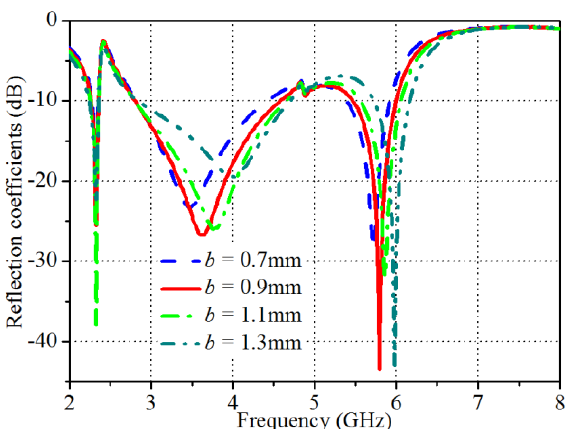
Figure 6: Effect of the design parameter b on the reflection coefficients.